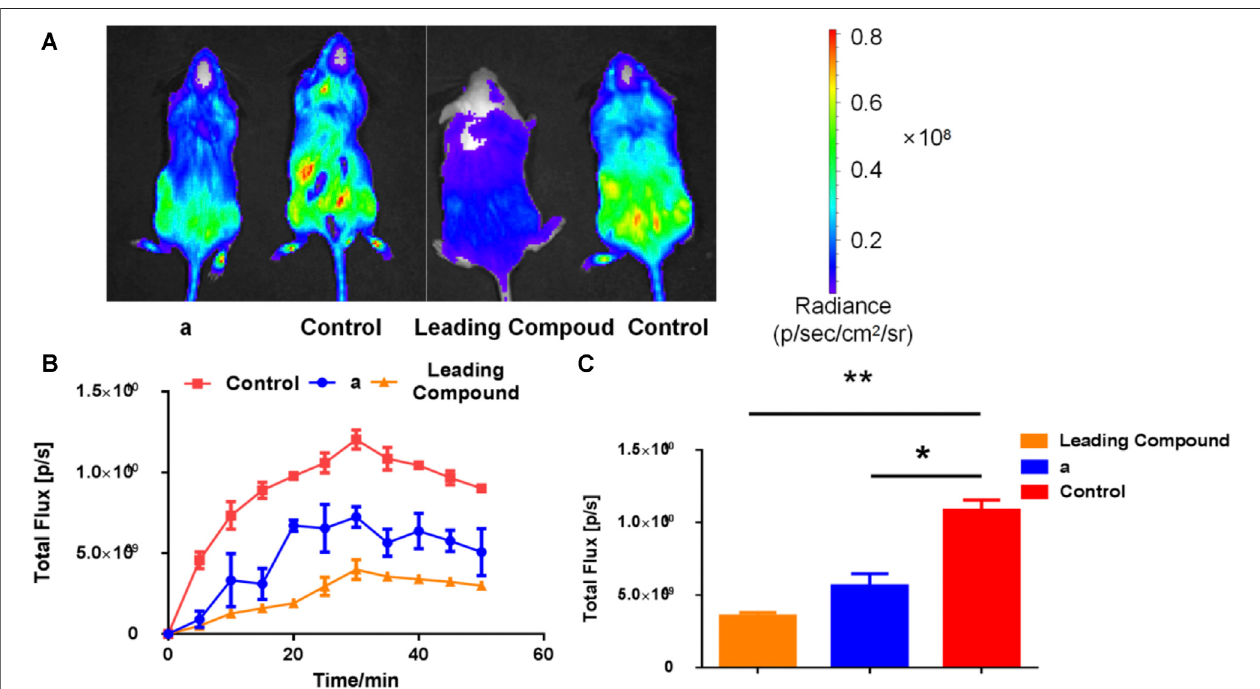
FIGURE6| Theexpressionofvanin-1enzymeinFVB-luc+transgenicmiceafteroraladministrationofinhibitors,andprobe(1 mM,200 μ l)wasinjected1.5 hlater. (A) Bioluminescence imaging pictures of compound a group (50 mg/kg) and lead compound group (25 mg/kg) 30 min after probe injection; (B) bioluminescence intensityinmiceatdifferenttimesafterprobeinjection (C) Softwareanalysis Figure4A isthebioluminescenceintensityvalue30 minaftertheprobeisinjected( n ≥ 3;* p < 0.05, ** p < 0.01 vs . Control).